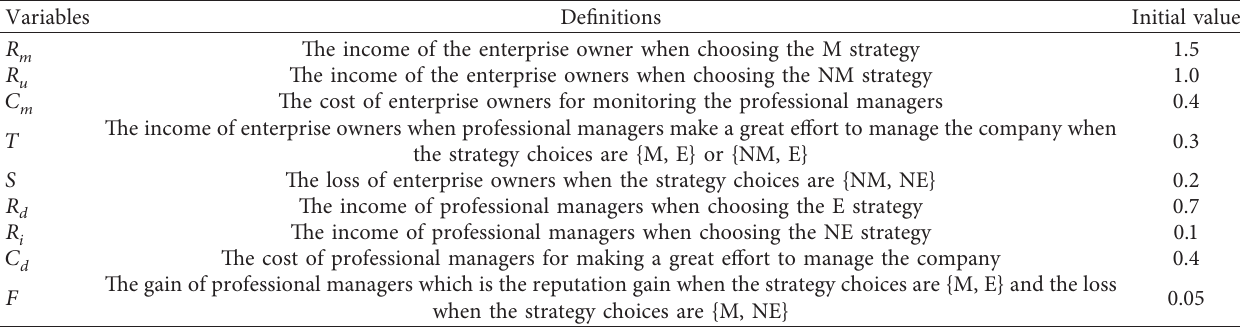
Figure 11: System dynamics model of principal-agent problem. Table 7: The external variables and initial values of the system dynamics